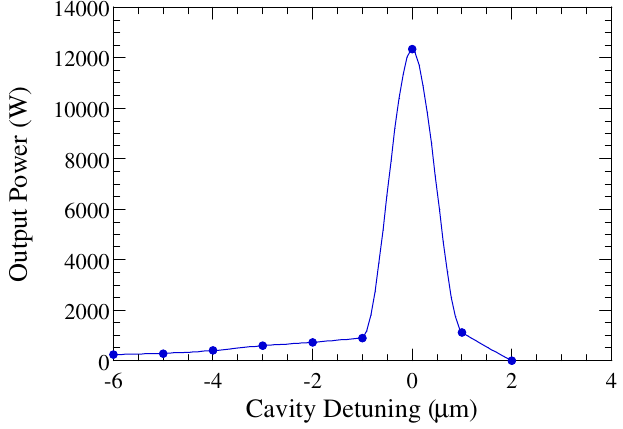
FIG. 11. (Color) Average output power versus cavity